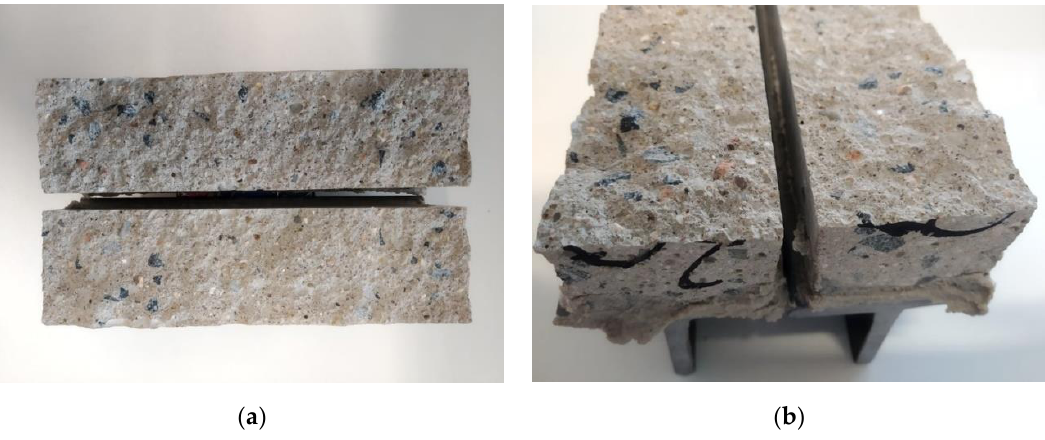
Figure 10. Failure of the specimens on the layer interface. ( a ) upper view; ( b ) detail view.